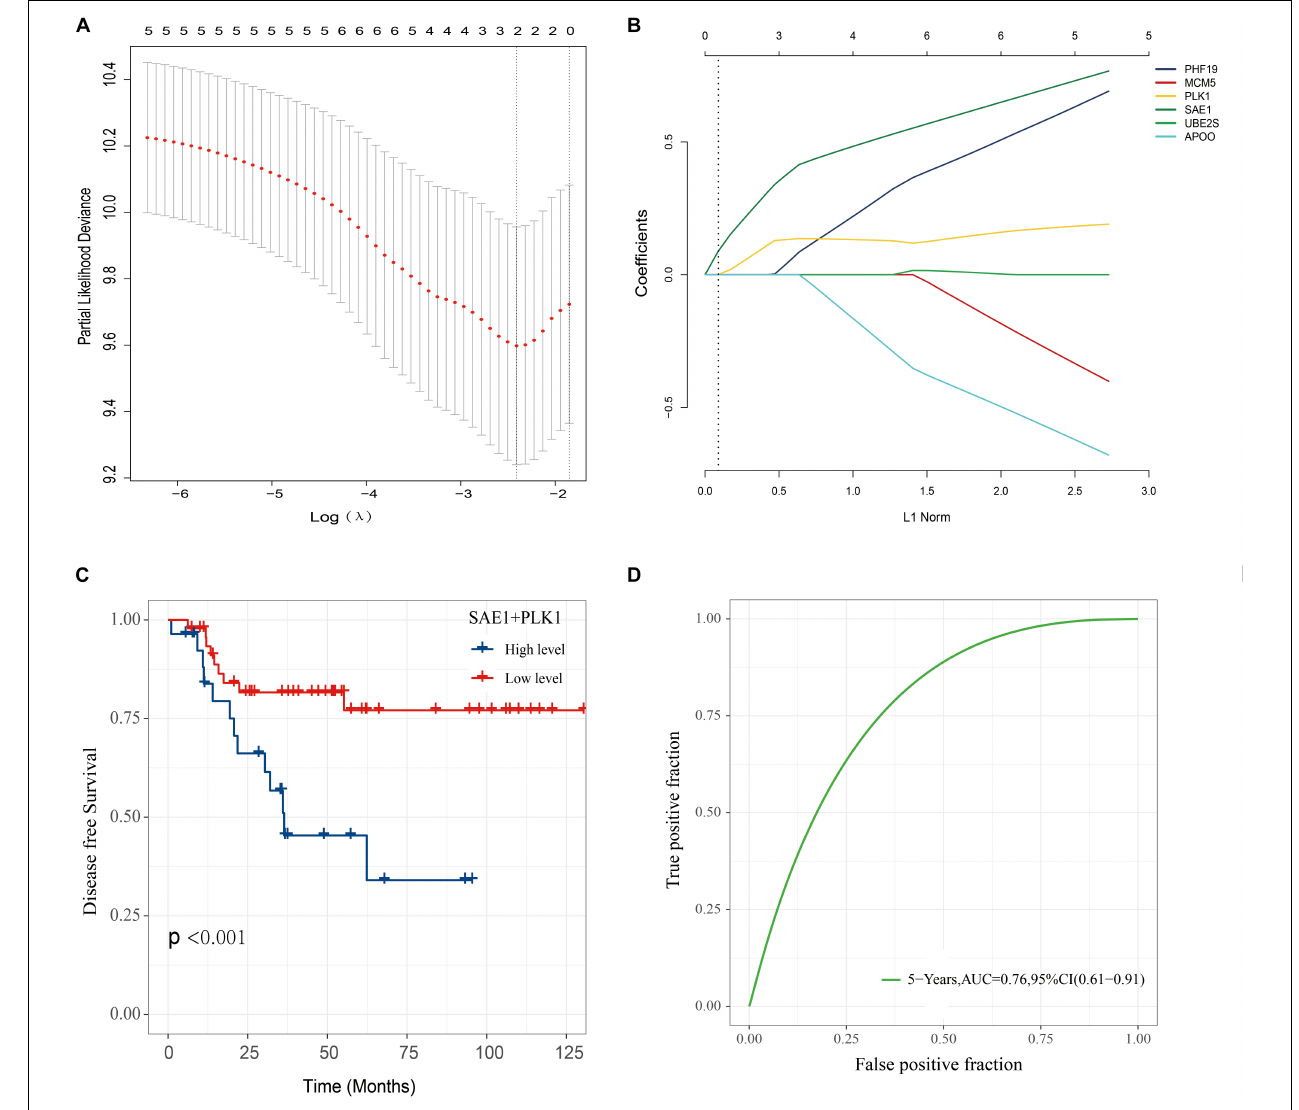
FIGURE 9 | Construction of a classifier to predict disease-free survival in TNBC patients. (A) Partial likelihood deviance of DFS for the LASSO coefficient profiles. (B) LASSO coefficient profiles of the SAE1, APOO, MCM5, PHF19, PLK1, and UBE2S expression for DFS. (C) Kaplan-Meier survival analysis showing the impact of the classifier on DFS. (D) ROC curves compare the prognostic accuracy of the classifier in TNBC patients using AUCs at 5 years to assess prognostic